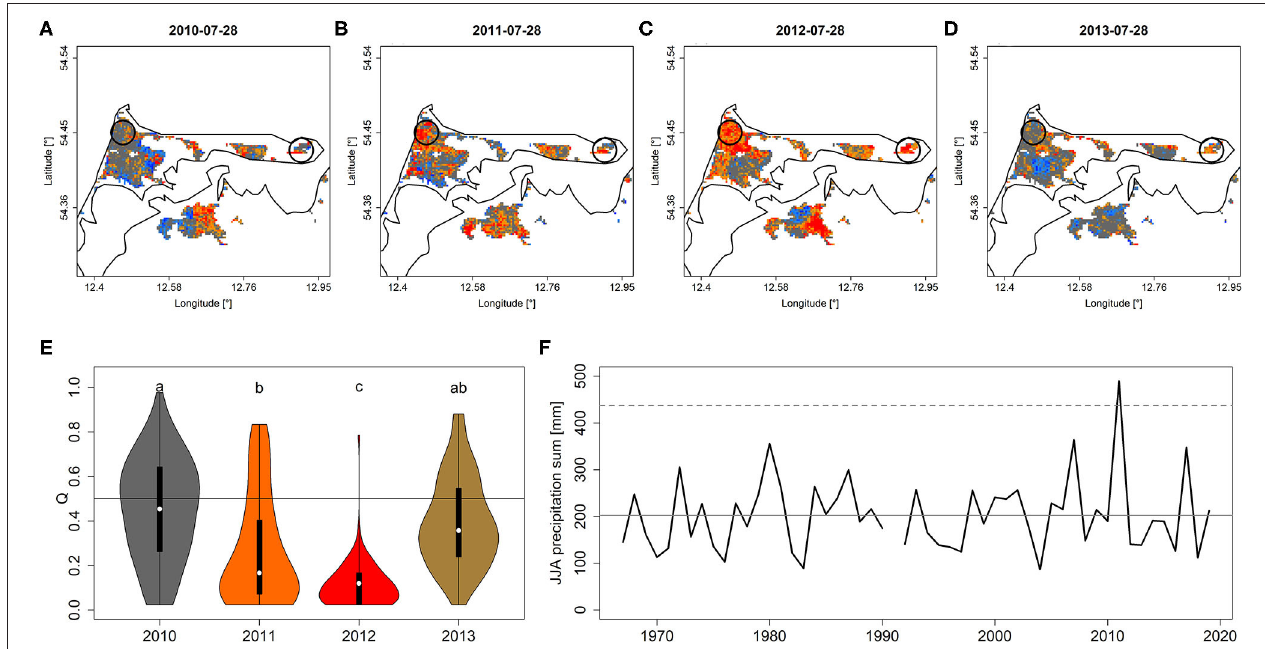
FIGURE 5 | Q depicted for peak season (July 28th) for each year from 2010 to 2013 (A–D) . Black circles refer to the areas that experienced increased die-back after 2011 (see also Supplementary Figures 8, 9 ) for which Q -values were extracted [shown in (E) ]. (F) June-August precipitation sum from a nearby climate station indicates the year 2011 to exceed the 99% confidence interval (dashed line). Minor case letters in (E) indicate group-assignment according to pairwise Wilcoxon rank-sum test. Colors in (E) refer to colors of mean quantiles per year. The gray vertical line in (F) refers to mean JJA precipitation sum. A similar figure but for PDM is shown in Supplementary Figure 7